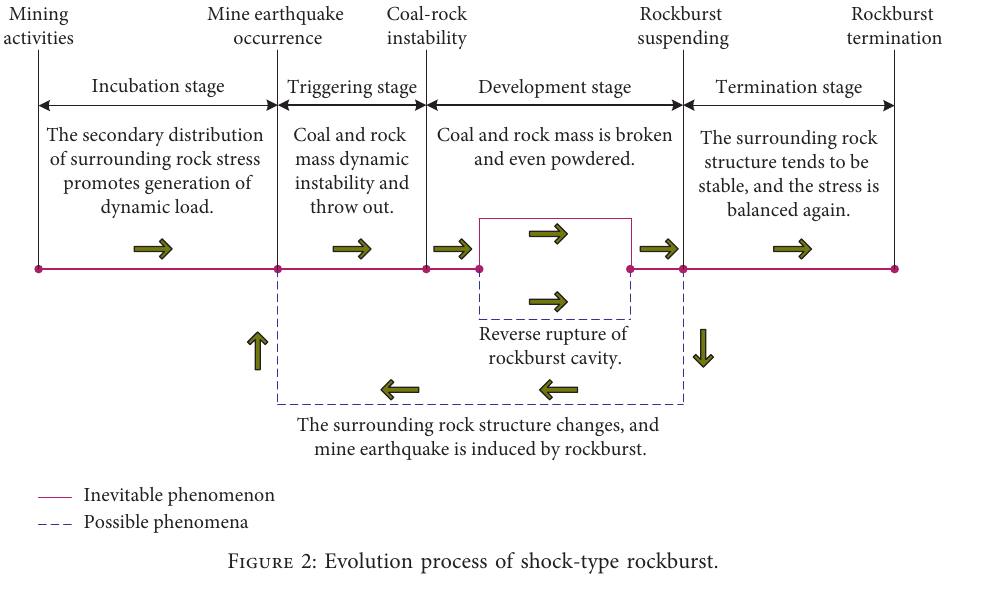
Figure 2: Evolution process of shock-type rockburst.